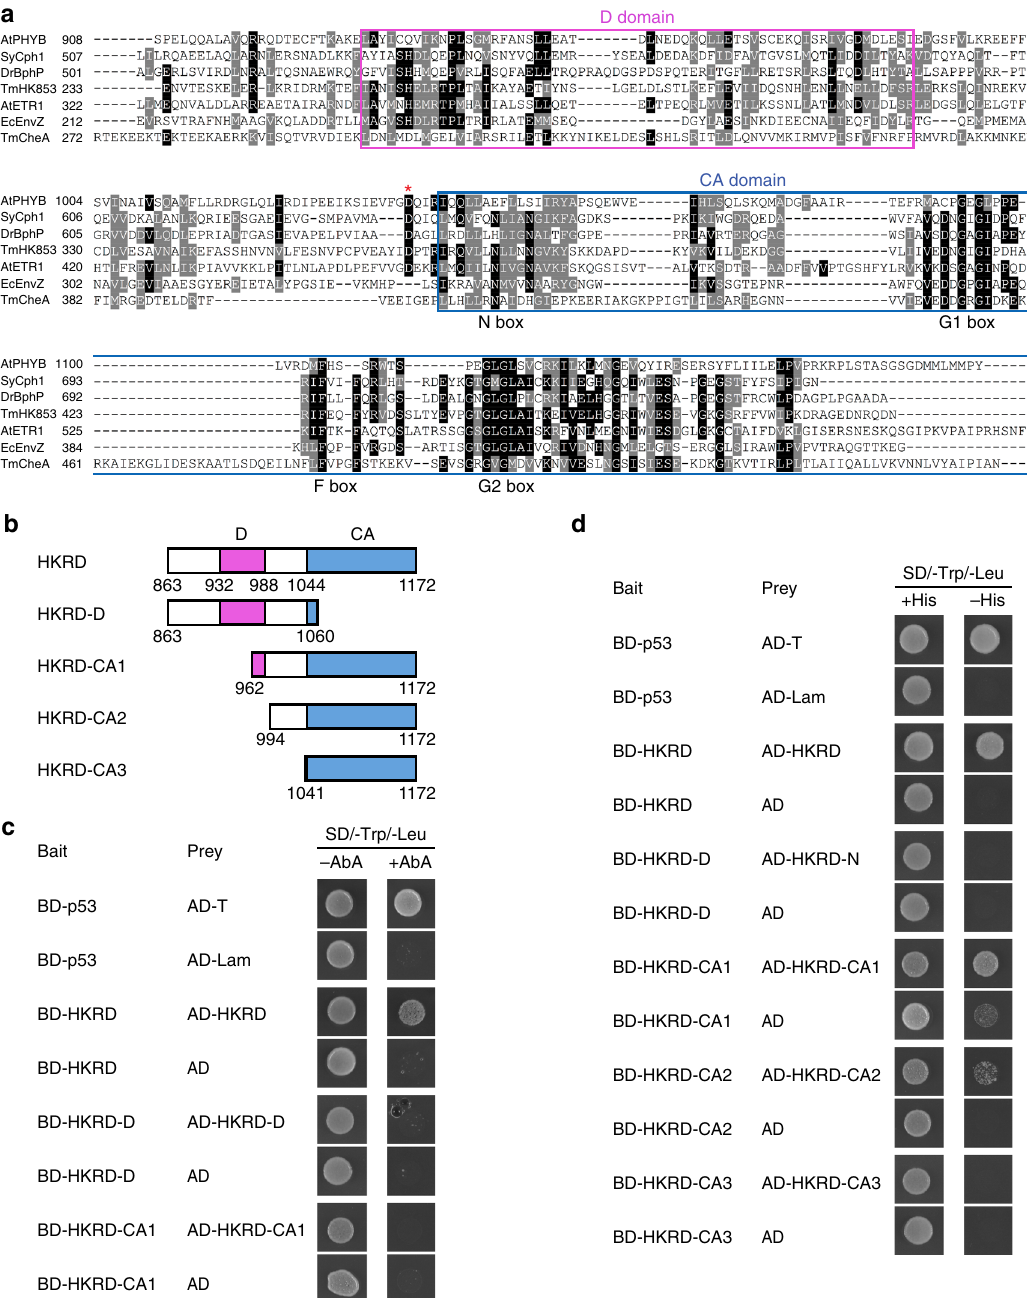
Fig. 6 The entire HKRD of PHYB is a dimerization domain. a Sequence alignment of the HKRD of PHYB with a number of well characterized canonical histidine kinase domains. Identical and similar amino acids are labeled in black and grey background, respectively. The purple box indicates the D domain of PHYB, which is de fi ned based on the DHp domain of EnvZ 80, 81 . The blue box indicates the CA domain, including the conserved N, G1, F, and G2 boxes, which are de fi ned based on the structure of CheA 82 . The red asterisk highlights the D1040 in PHYB. GenBank accession numbers for the selected sequences are: SyCph1, Q55168.1; DrBphP, Q9RZA4.1; TmHK853, Q9WZV7; AtETR1, AAA70047.1; EcEnvZ, P0AEJ4.1; AtphyB, P14713.1; TmCheA, Q56310.2. b Schematic illustration of the HKRD fragments used for determining the dimerization domain. The D and CA domains are labeled with magenta and blue boxes, respectively. The numbers indicate the positions of amino acids. c Yeast two-hybrid results showing that both the D and CA domains are required for HKRD dimerization. Yeast cells carrying the indicated Bait and Prey constructs were grown on Synthetically-De fi ned (SD)/-Trp/-Leu selective minimal media with or without 125 ng/ml Aureobasidin A (AbA). Yeast growth in the presence of AbA indicates interaction between the bait and prey proteins. BD, GAL4 DNA-binding domain; AD, GAL4 activation domain; T, SV40 large T antigen; Lam, Lamin. BD-p53/AD-T and BD-p53/AD-Lam are positive and negative controls, respectively. Each bait construct was tested for self-activation by co-transformed with an empty prey vector expressing only AD. d Yeast two-hybrid results showing weaker interactions between full-length and fragments of the HKRD on less stringent selective media: SD/-Trp/- Leu or SD/-Trp/-Leu/-His selective media in the absence of AbA. Yeast growth on the SD/-Trp/-Leu/-His plate indicates interaction between the bait and prey proteins. BD GAL4 DNA-binding domain, AD GAL4 activation domain, T SV40 large T antigen, Lam